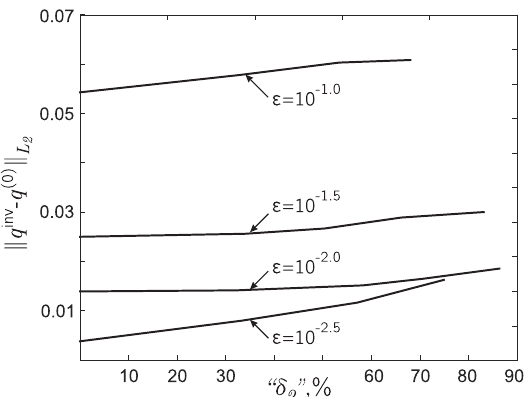
Figure 9. The norm of the residual (cid:107) q inv − q ( 0 ) (cid:107) L data for various ε (“ δ 1 ” =